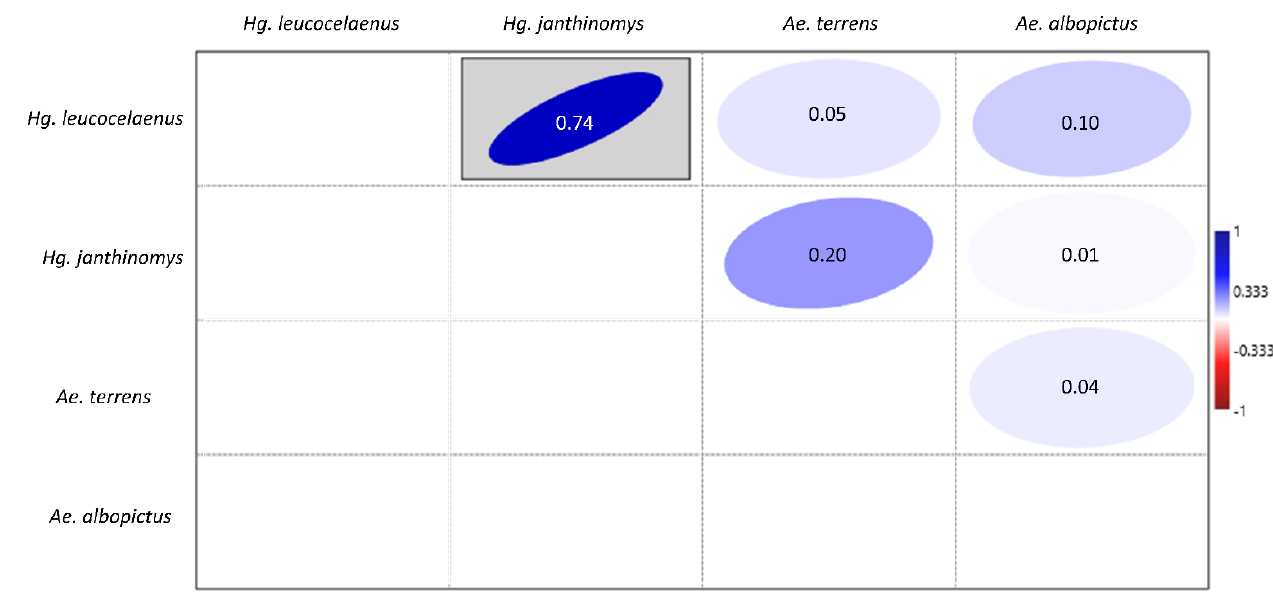
Figure 6. Spearman’s correlation for the abundance of eggs of Culicidae species Hg. leucocelaenus , Hg. janthinomys , Ae. albopictus , and Ae. terrens that oviposited on the same paddles from September 2019 to January 2021 in RPPN Gaviões. p ≤ 0.05.